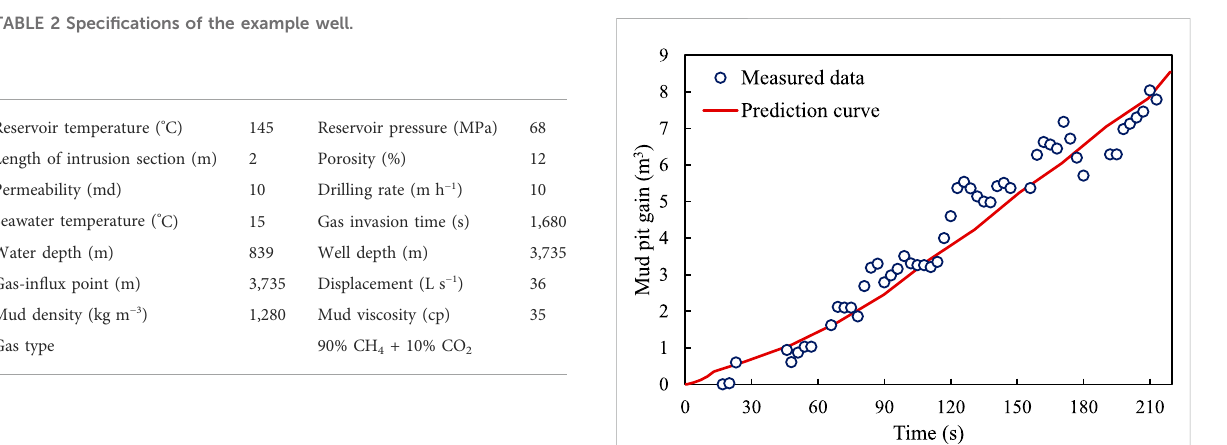
FIGURE 7 Variation in the relationship between mud-pit increment and bottom-hole pressure with invasion